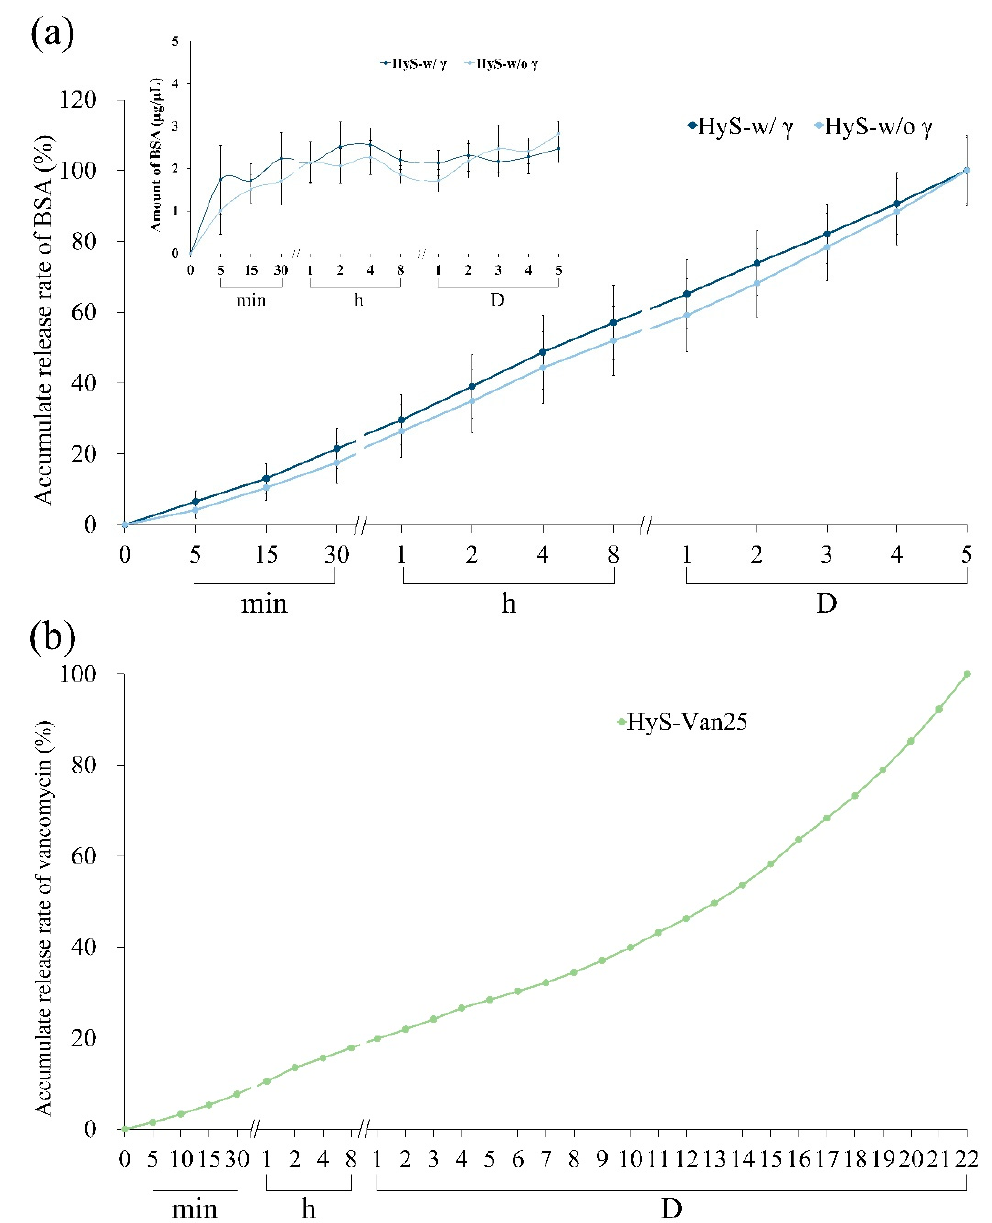
Figure 6. Protein release of BSA before (HyS-w/o γ ) and after (HyS-w/ γ ) sterilization of hydrogel macrospheres in vitro ( n = 10) ( a ) and cumulative antibiotic release of hydrogel macrospheres impregnated with vancomycin after sterilization (HyS-Van25, n = 10) ( b ).